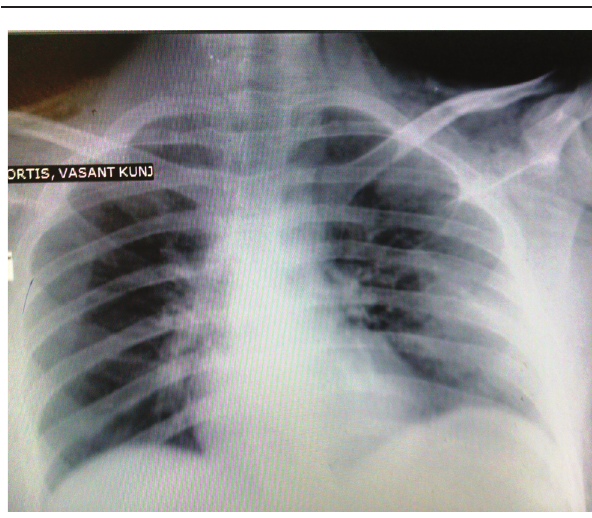
Chest radiography showing hyperinflation of lung fields.